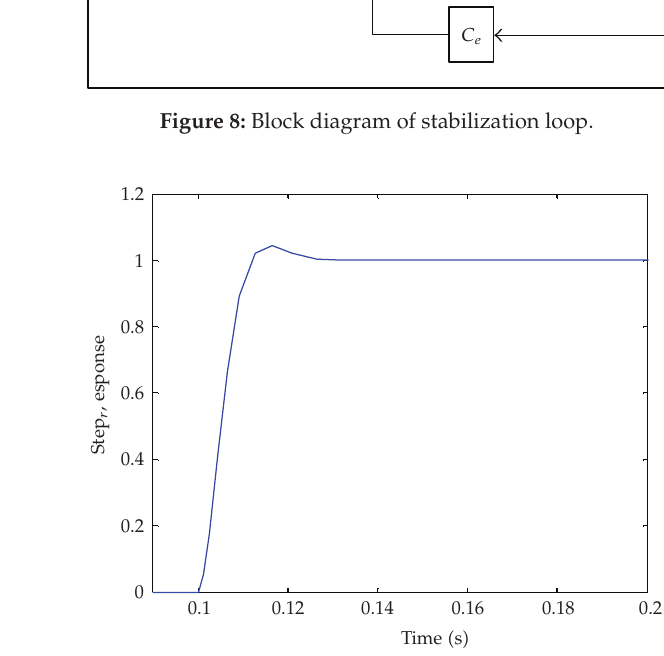
Figure 9: Step response of tracking